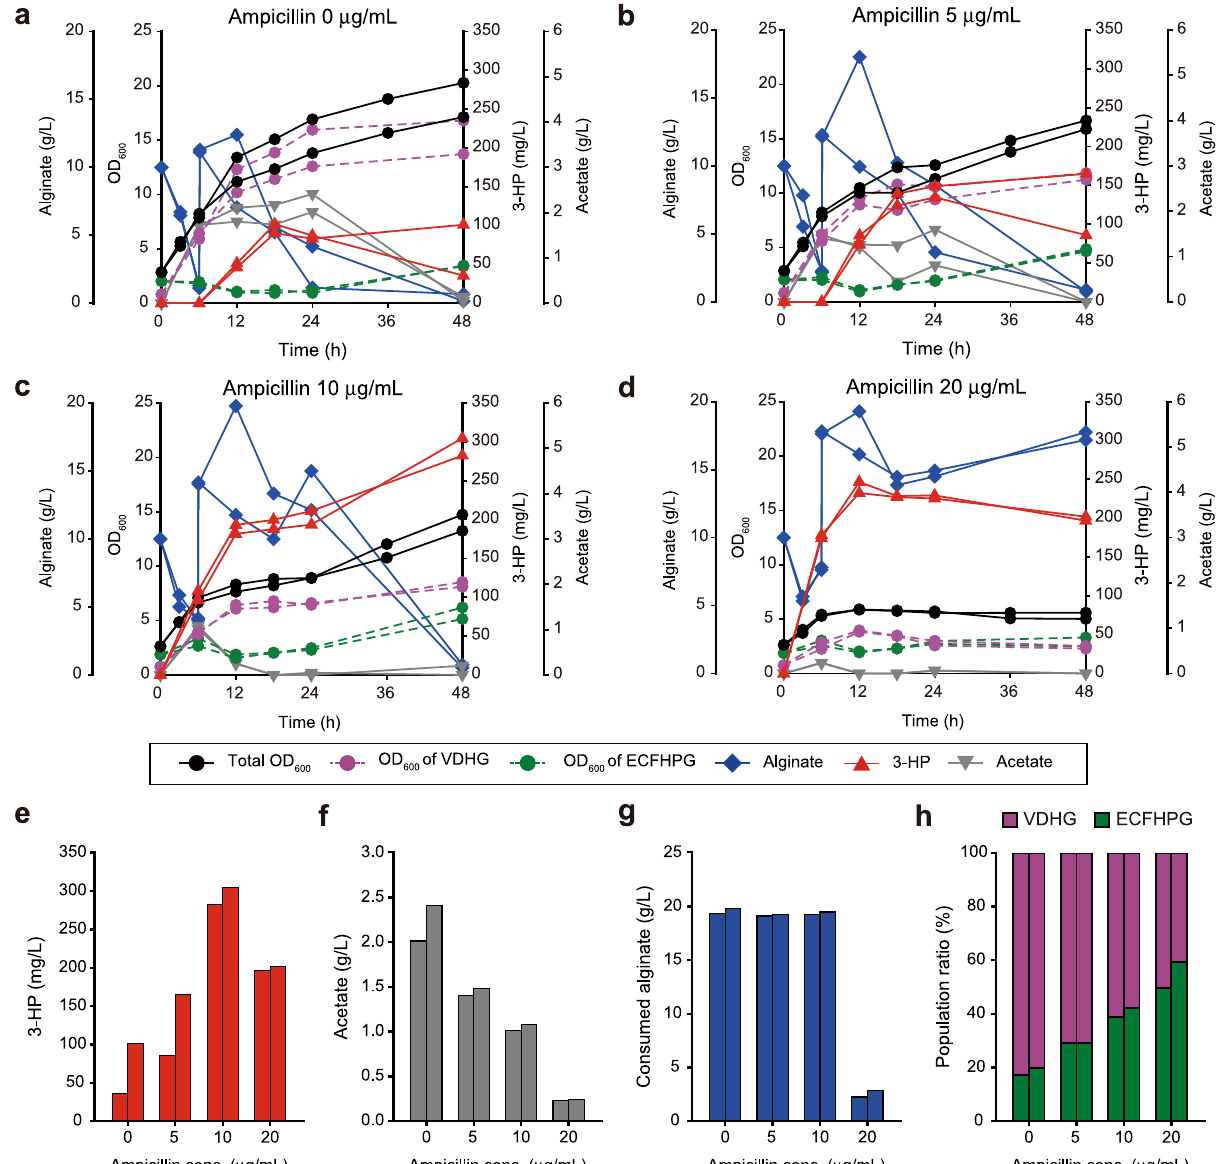
Fig. 4 | Improved 3-HP production upon the synthetic acclimation of the microbial consortium. a – d Fermentation pro fi les of the co-culture of the VDHG and ECFHPG strains with the addition of ( a ) 0, ( b ) 5, ( c ) 10, and ( d ) 20 µ g/mL ampicillin. The left y -axis represents OD 600 of cultures (black circles). Estimated OD 600 of the VDHG (purple circles) and ECFHPG (green circles) strains was also provided. The left y -offset, right y -axis and right y -offset represent alginate (blue